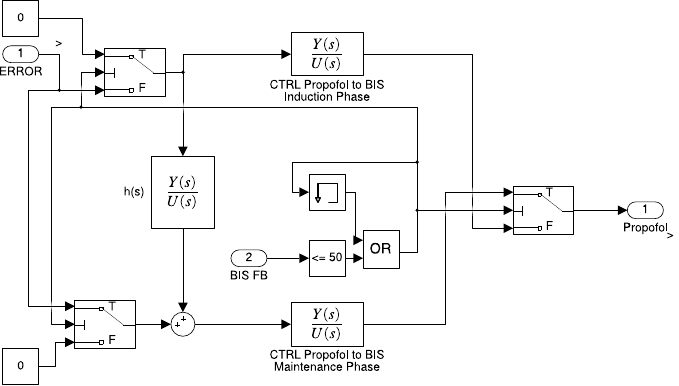
Figure 12. Bumpless transfer implementation for the combined induction and maintenance control on BIS.